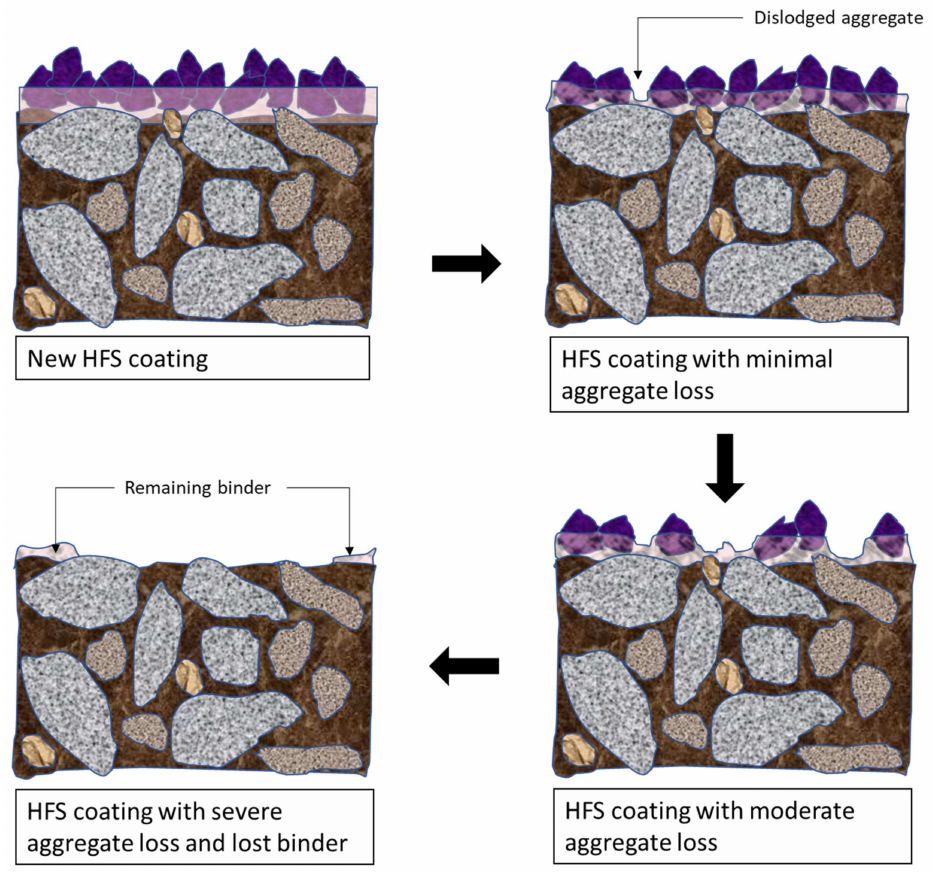
Figure 4. Illustration of the aggregate loss process in a HFS